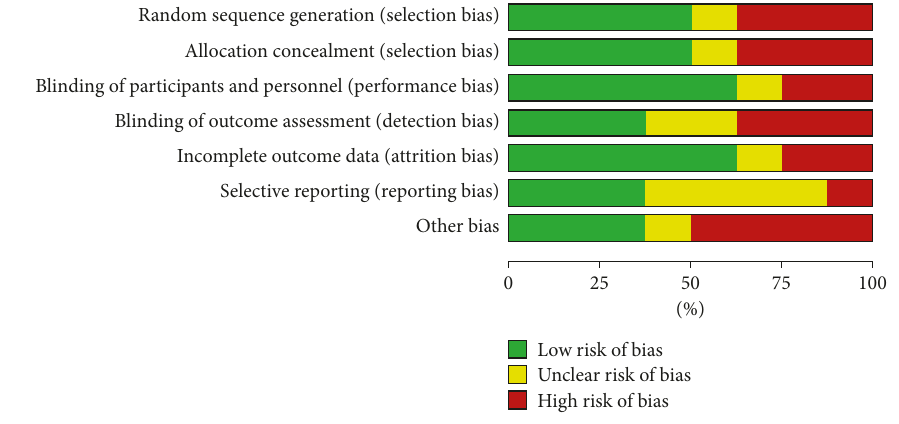
Figure 2: Risk bias